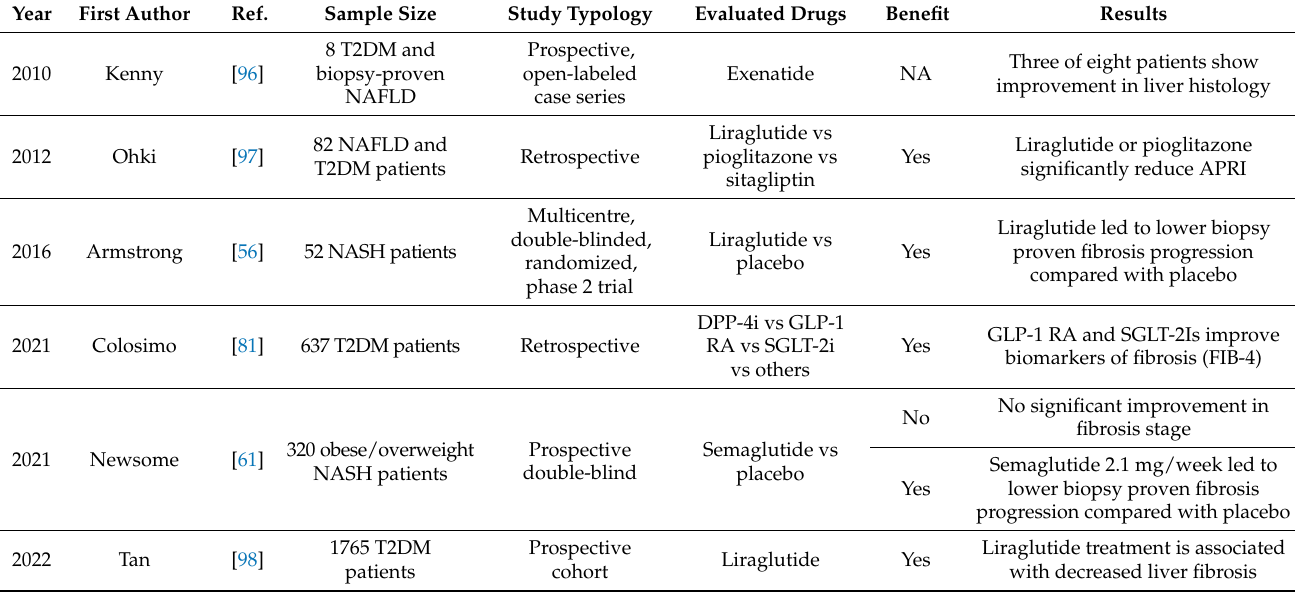
Table 4. Main evidences on the effect of GLP-1 RA on liver